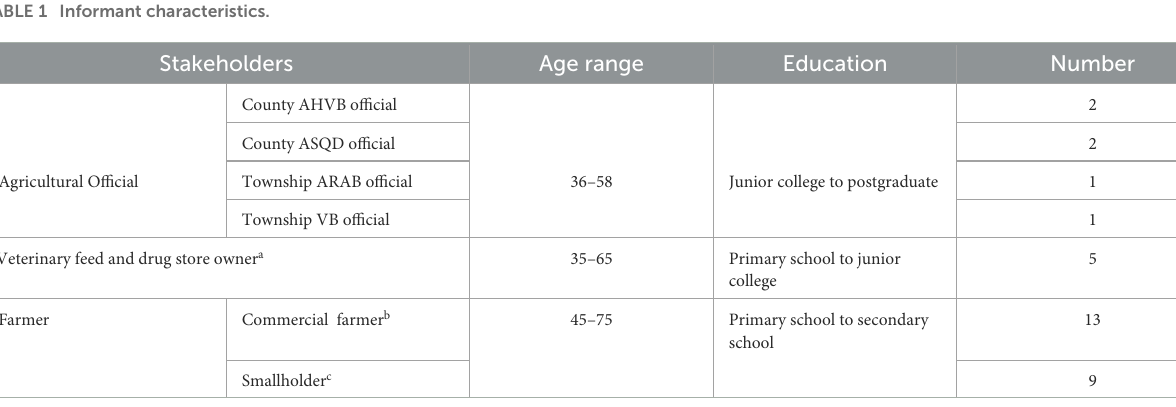
TABLE 1 Informant